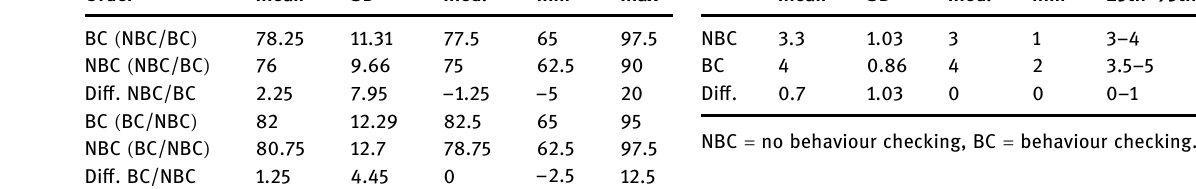
Table 4: SUS response in terms of presentation order